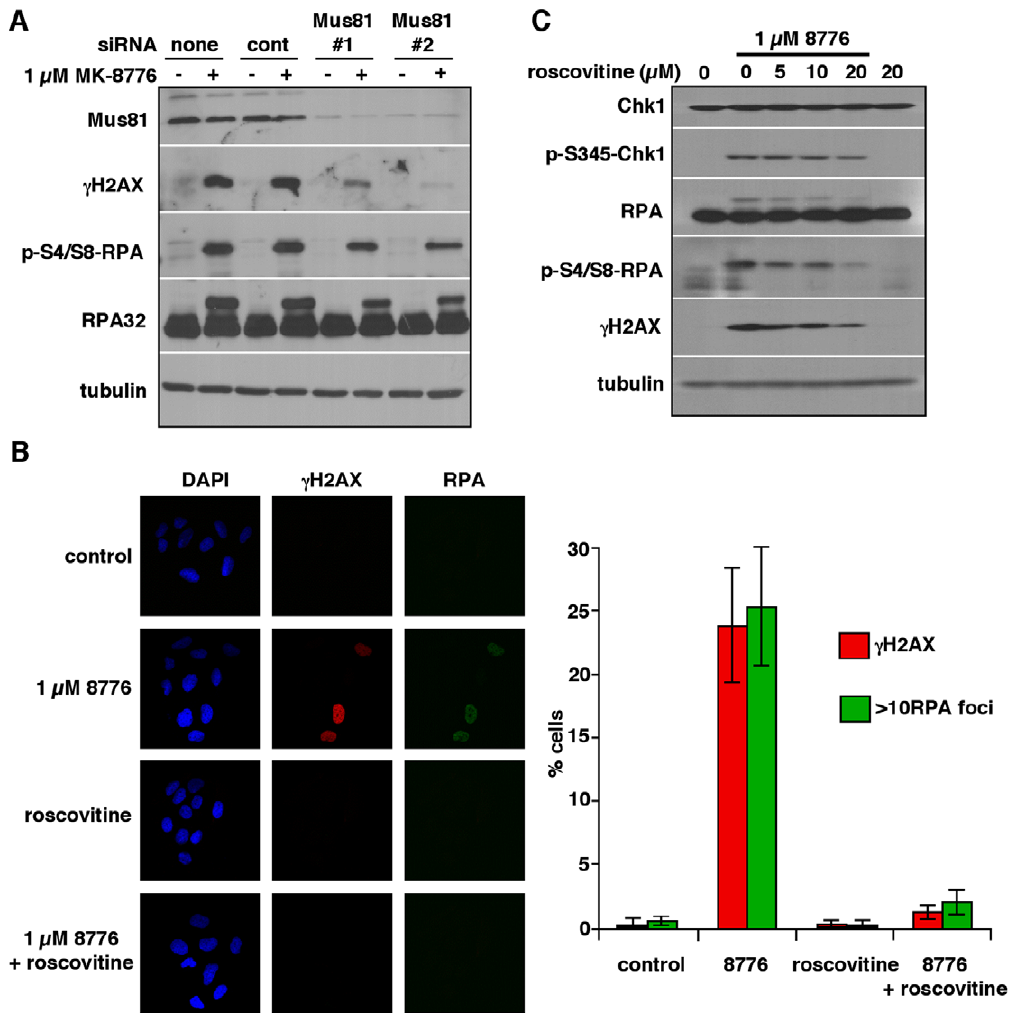
Figure 3. The role of Mus81 and CDK2 in MK-8776-induced DNA damage. A. Cells were transfected with siRNA against Mus81 then analyzed by western blotting for markers of DNA damage following a 6-h treatment with MK-8776. B. U2OS cells grown on coverslips were incubated with 1 m M MK-8776, 20 m M roscovitine or both for 6 h then stained with the indicated antibodies and analyzed by confocal microscopy. 100 cells were scored for each condition and are presented as histograms. Error bars represent the standard error of 2 independent experiments. C. U2OS cells were co-incubated with MK-8776 and roscovitine for 6 h and analyzed by western blotting.